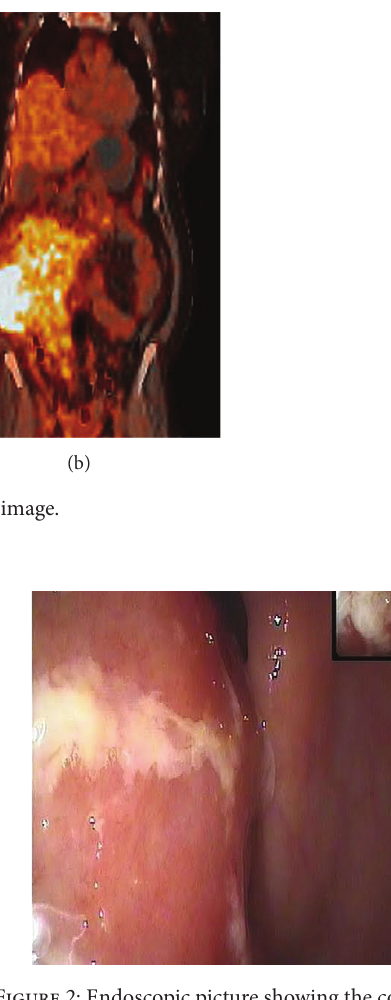
Figure 2: Endoscopic picture showing the colonic mass.